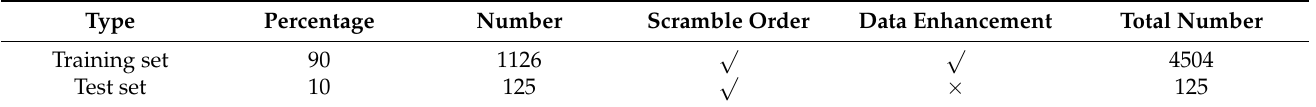
Table 3. Experimental data is randomly divided according to the